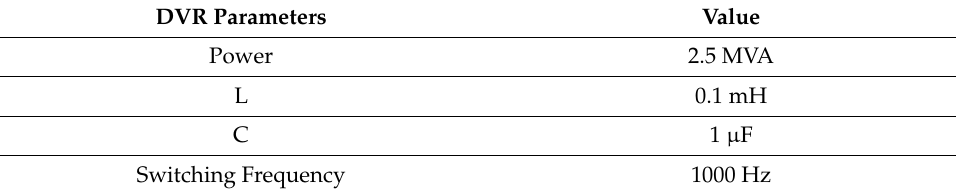
Table 5. DVR parameters.